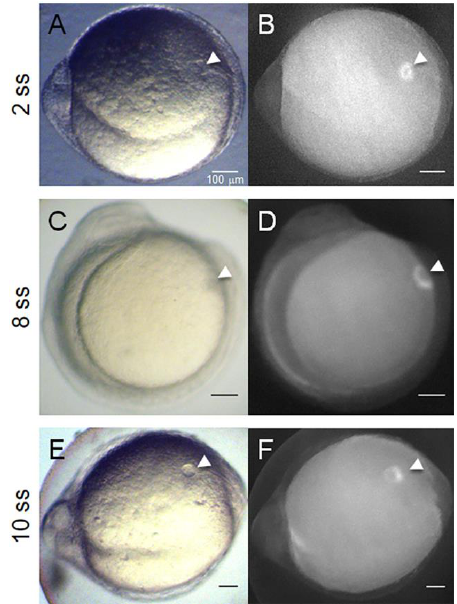
Figure 2. The zebrafish KV—a model organ to study cyst inflation. The KV localized at the tail region of a 2–14 ss zebrafish embryo. TgBAC(cftr-GFP)pd1041 zebrafish line characterization. ( A , C , E ) are bright field captured images. ( B , D , F ) were acquired by fluorescence stereomicroscopy. White arrowheads indicate the KV. Scale bars: 100 µ